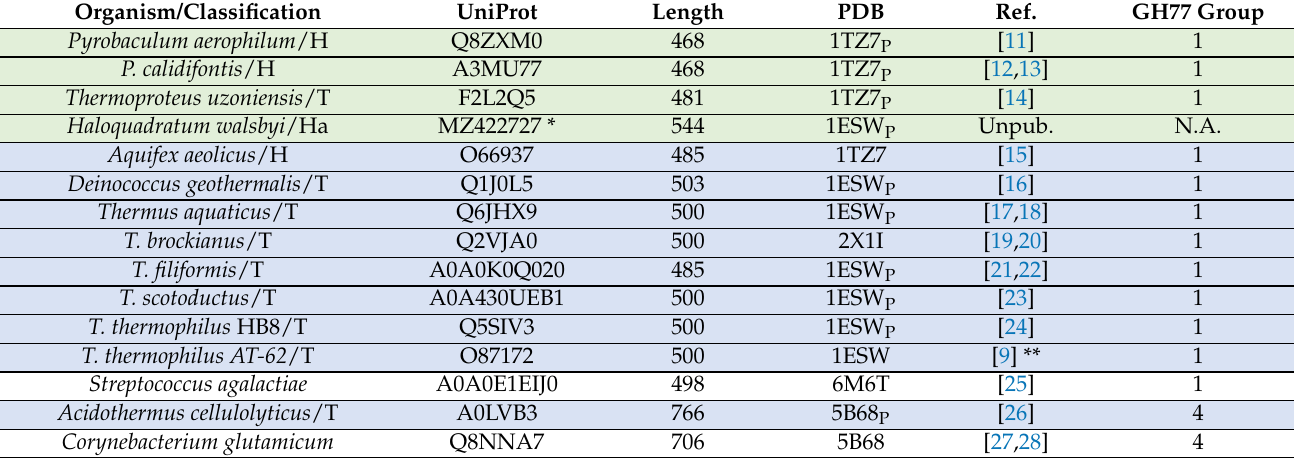
Table 1. Amylomaltases characterized in extreme Archaea (green background) and Bacteria (cyan background).